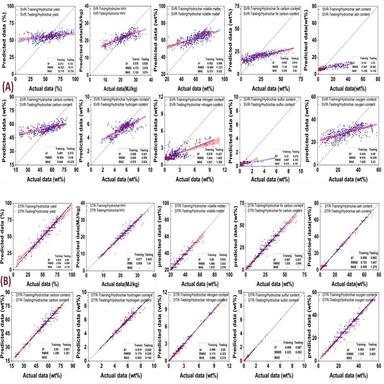
Comparing model-predicted values with actual data. (A) SVR and (B) DTR. Abbreviation: Support vector regression (SVR) and Decision tree regression (DTR).